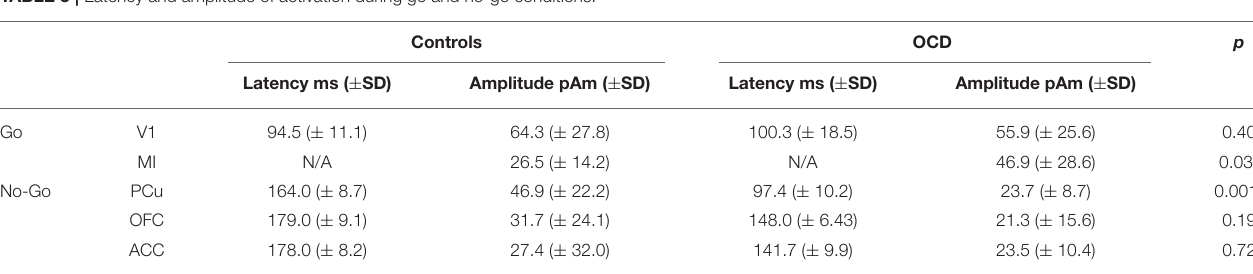
TABLE 3 | Latency and amplitude of activation during go and no-go conditions. Controls OCD p Latency ms ( ±